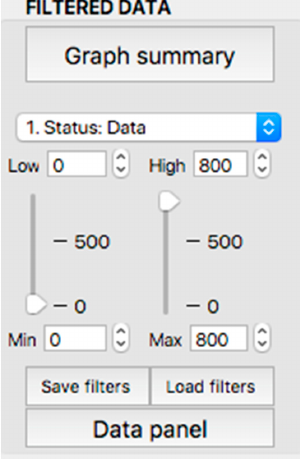
Figure 11. Display of the “filtered data” panel (panel 3).